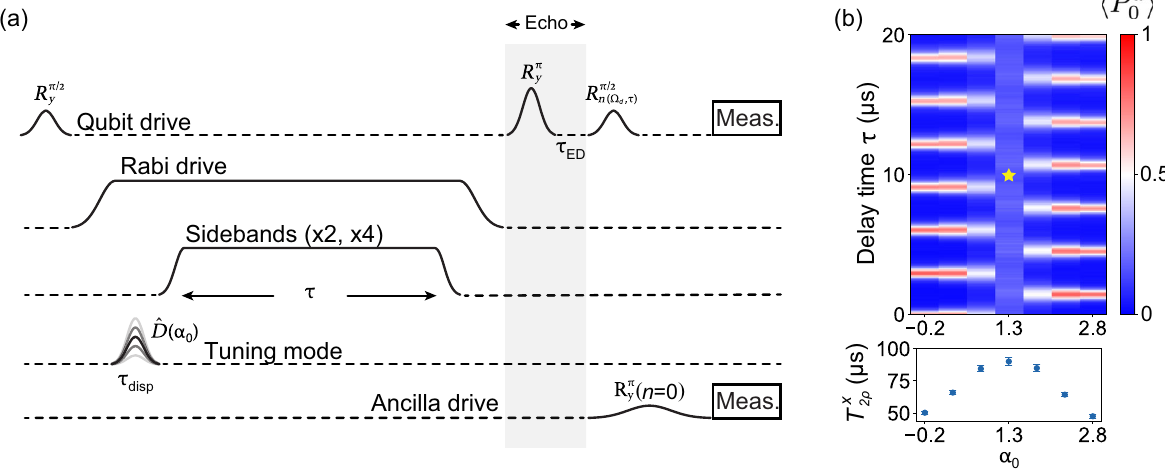
FIG. 10. Calibrating conditional displacements. (a) Pulse sequence. The displacement pulse is played after the Rabi drive is turned on and the cross-Kerr is nulled. An echo sequence eliminates the residual entanglement between the qubit and cavity during the ramp off of the Rabi drive. (b) Top: coherent revivals for various initial displacements along the interaction axis, probed through measurement of the vacuum projector. The contrast is maximized when the wave packet passes through the origin, and oscillations vanish when the ground ≈ 1 . 3 is prepared. The data in Fig. 3(b) are taken at the location of the yellow star. Bottom: simultaneous measurement of T x state α g reveals driven coherence times with a slight dependence on h ˆ a † ˆ a i